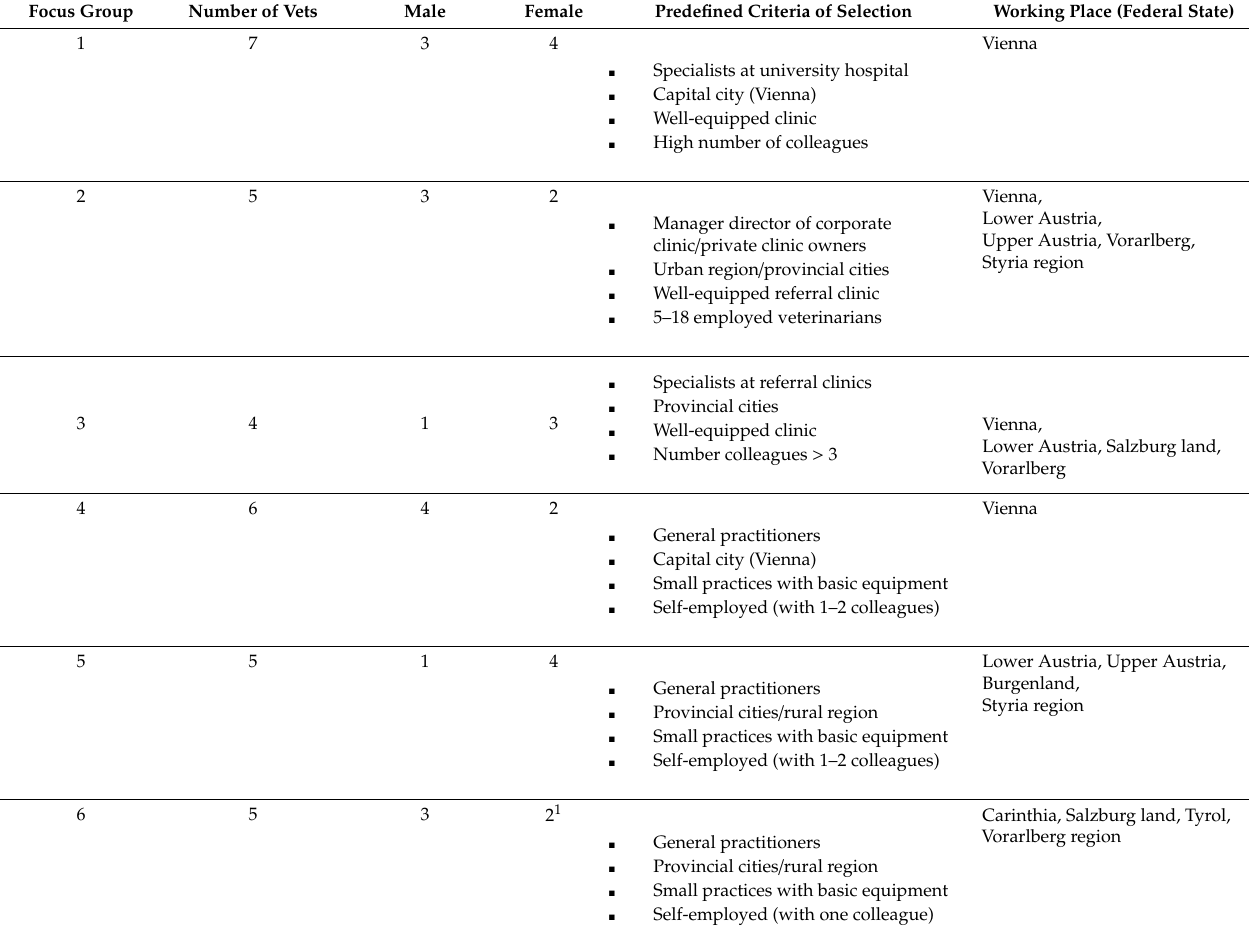
Table 1. Details about focus group participants and composition ( n =